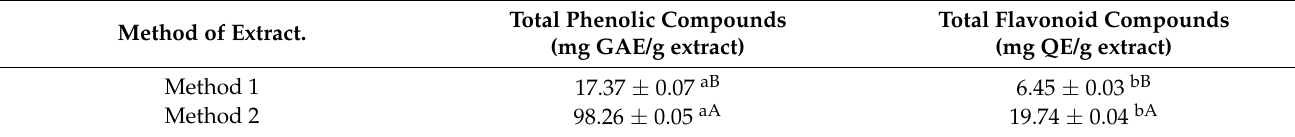
Table 1. Total phenolic and total flavonoid compounds. Method of